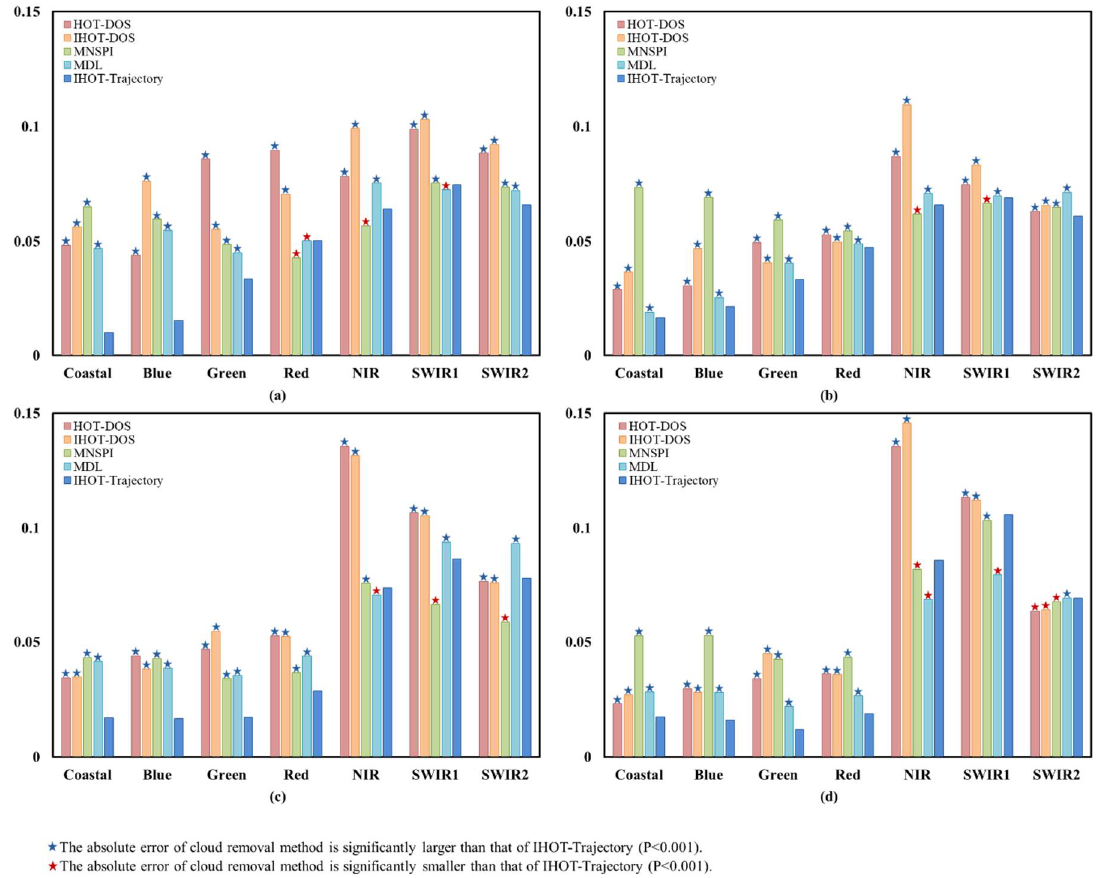
Figure 8. Root mean square error (RMSE) between the reference image and the restored image using HOT-DOS, IHOT-DOS, IHOT-Trajectory, MNSPI and MDL. ( a – d ) correspond to RMSE of Figures 5b,c and 6b,c, respectively.